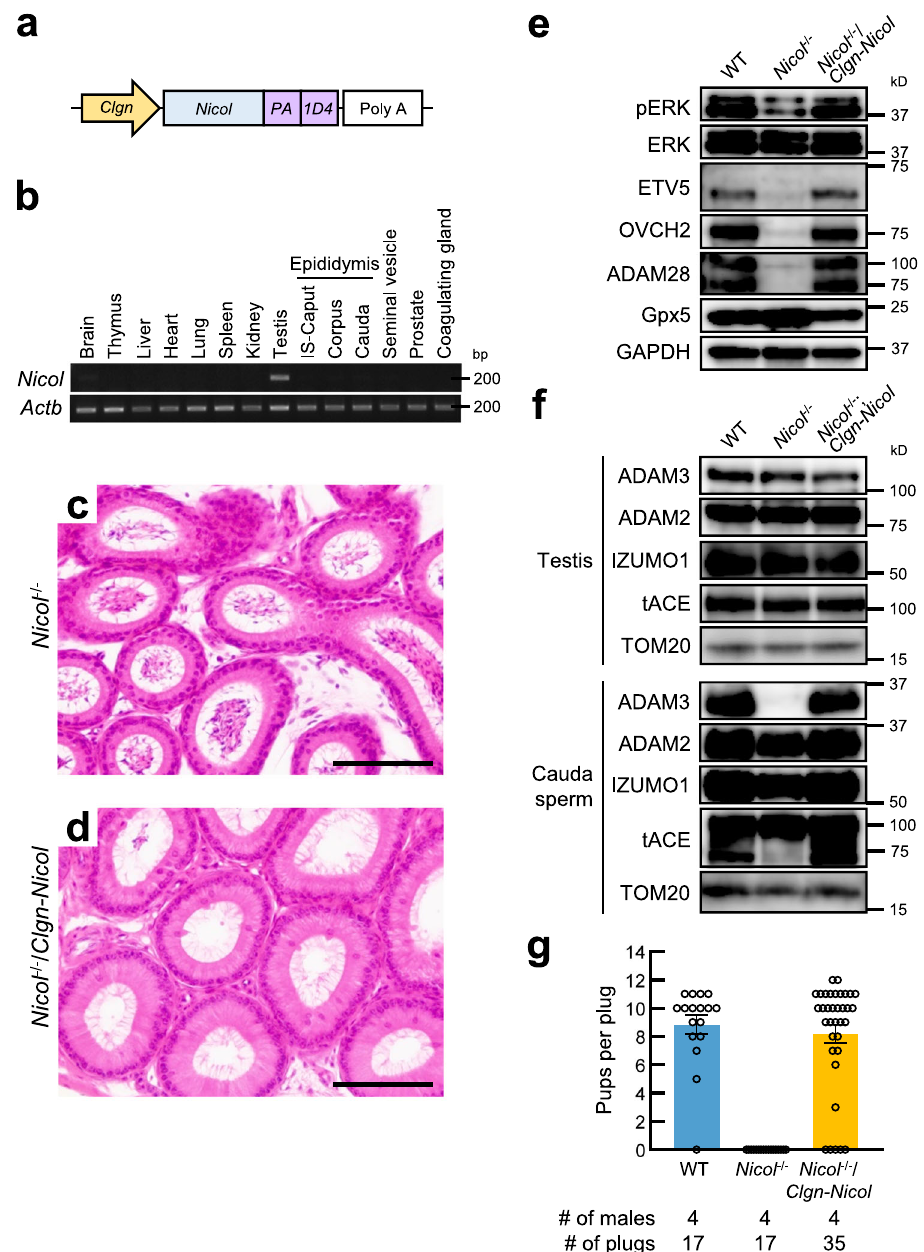
Fig. 6 | Testicular germ cell-speci fi c expression of Nicol rescued epididymal differentiation, sperm maturation, and male infertility in Nicol − / − mice. a Schematic representation of transgene Clgn-Nicol . b RT-PCR analyses of Clgn- Nicol transgeneinbrain(Br),testis(Te),andcaputepididymis(Cap)in Nicol − / − / Clgn- Nicol mice. Actb shownasinternalcontrol.Imagesarerepresentativeonesobtained from three independent biological replicates. c , d HE staining of Nicol − / − ( c ) and Nicol − / − / Clgn-Nicol ( d ) IS. Bars, 100 µ m. e Immunoblot analyses of phosphorylated ERK, ETV5, OVCH2, and ADAM28 in WT, Nicol − / − , and Nicol − / − / Clgn-Nicol IS-caput